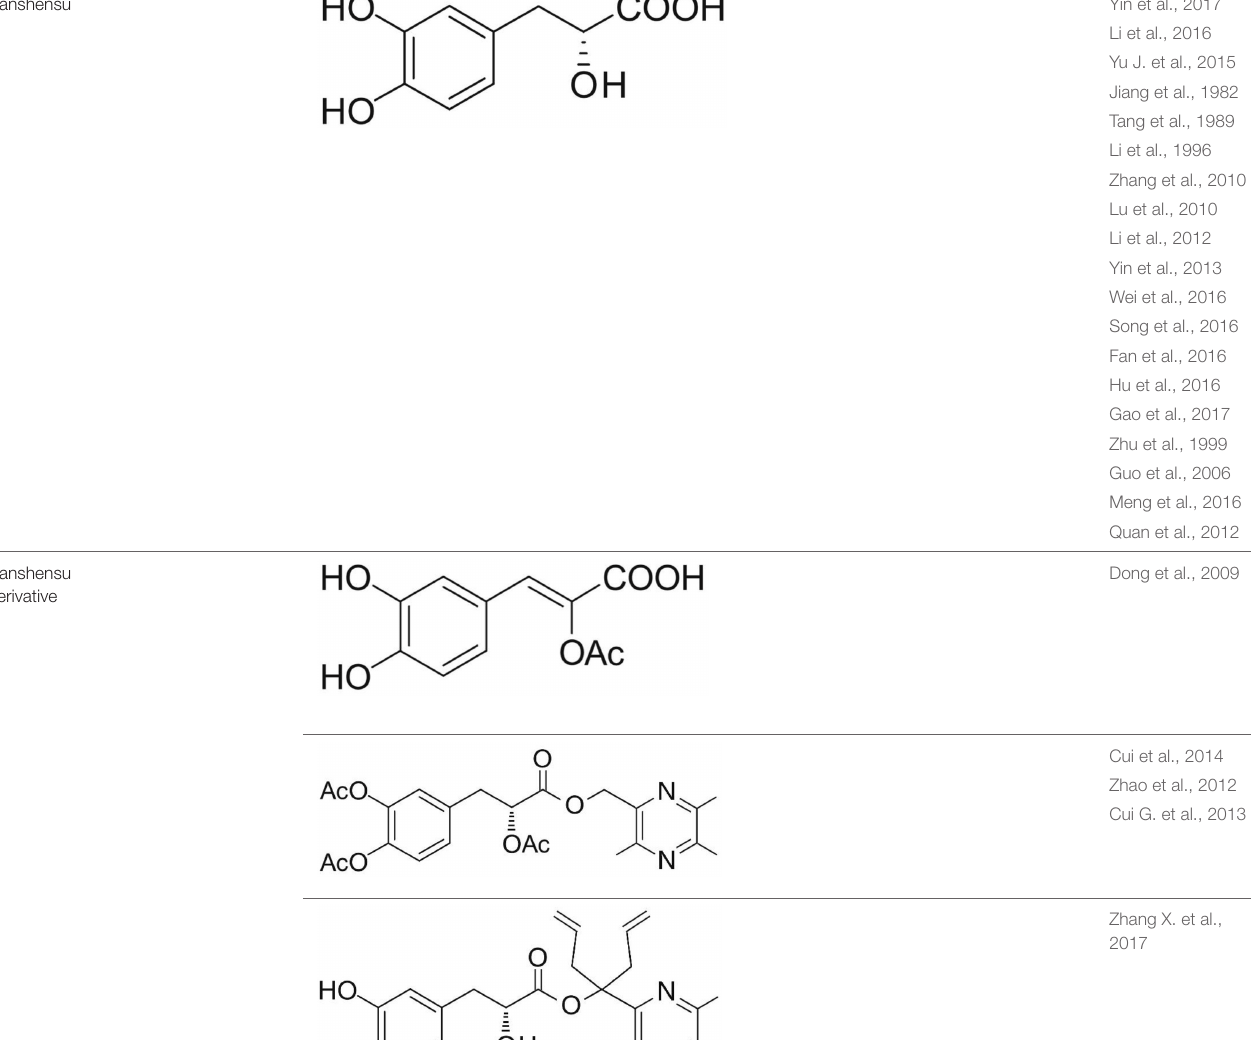
TABLE 1 | Specific chemical structures of Danshensu and its